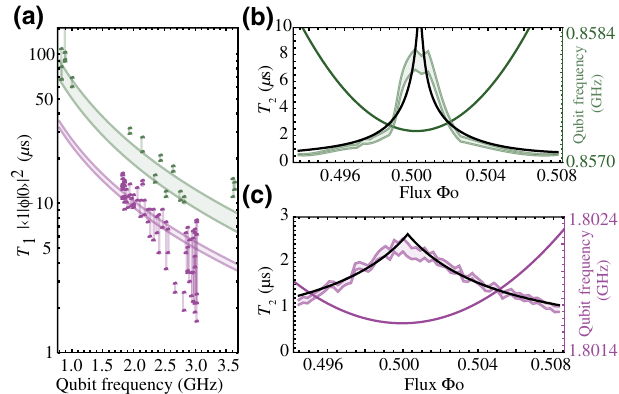
FIG. 4. The time-domain loss analysis. (a) The measured energy-relaxation time multiplied by the flux matrix element squared T 1 |(cid:7) 0 | ˆ φ | 1 (cid:8)| 2 of the fluxonium qubit E (green) and the quasicharge qubit F (purple) as a function of the external-flux- controlled qubit frequency. The bands are fits to the dielectric loss model given in Eq. (3), with the fit parameter Q diel for qubits as a func- E and F. (b),(c) The measured coherence time T echo 2 tion of the external flux around half flux for qubits E and F. The bands represent the 90% confidence interval of the spin-echo sequence fit: the black line is a fit to the flux-noise decoherence model given in Eq. (4) and the purple (green) solid lines show the calculated qubit transition frequency (right